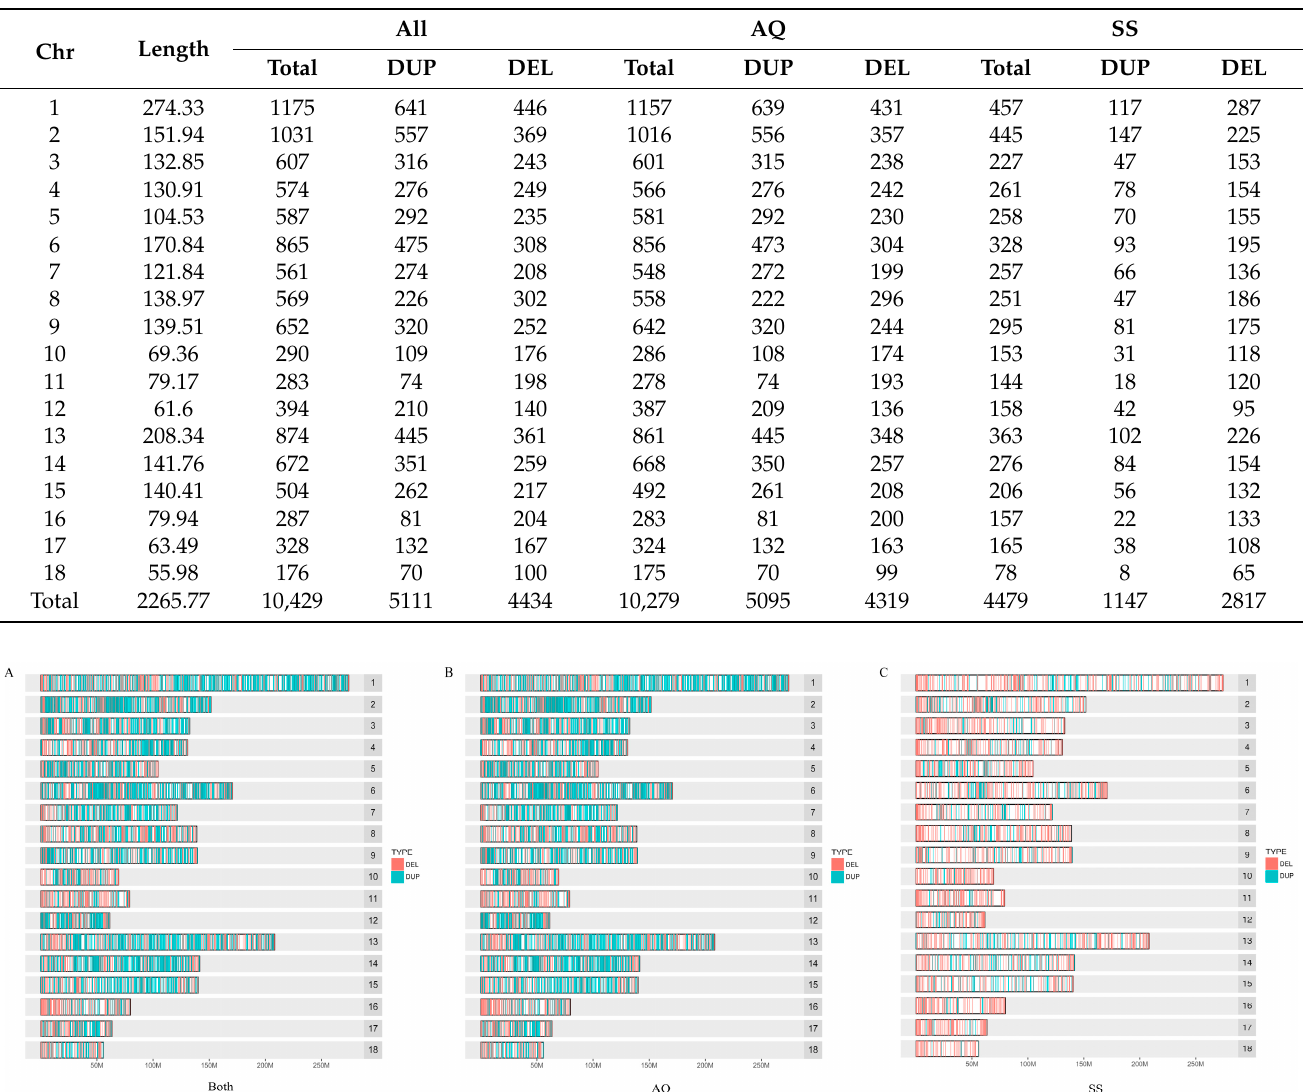
Table 1. The distribution of CNVRs in each chromosome of pig genome. Numbers of individual type and total CNVRs on 18 autosomal chromosomes were listed in different populations.